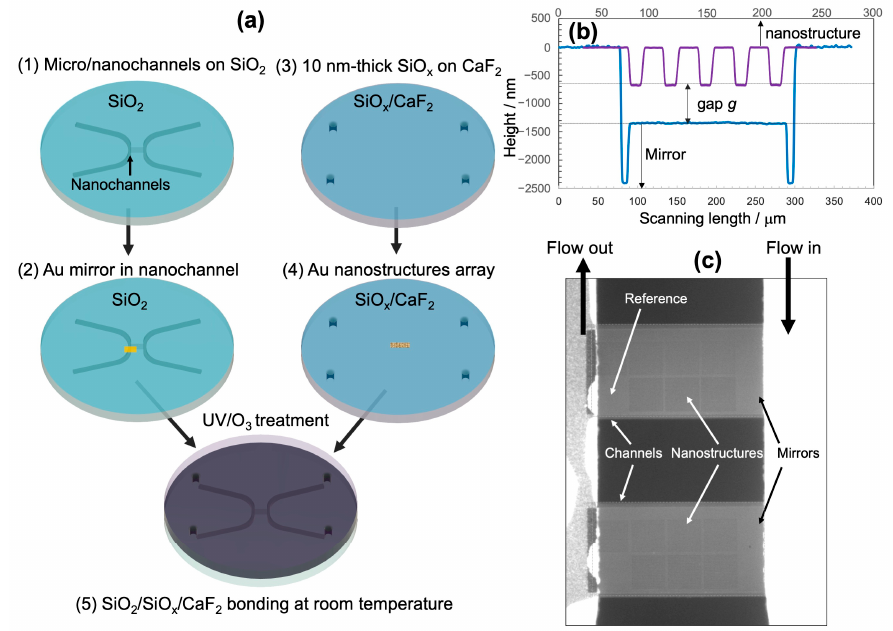
Figure 2. ( a ) Fabrication process of the infrared (IR)-compatible nanofluidic device integrated with MIM perfect absorber metamaterials, ( b ) nanogap g calculated from the height profiles of the bottom nanochannel and top nanostructure, and ( c ) fluorescence image of nanochannels confirming the success of